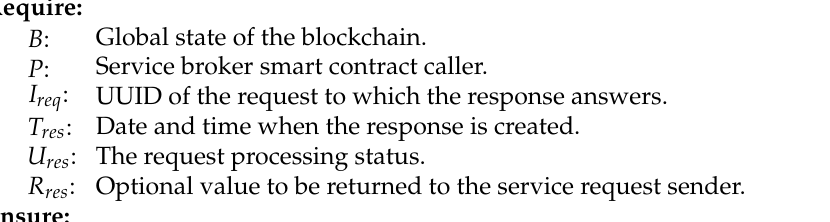
Algorithm 4 Responding to a service request using the service